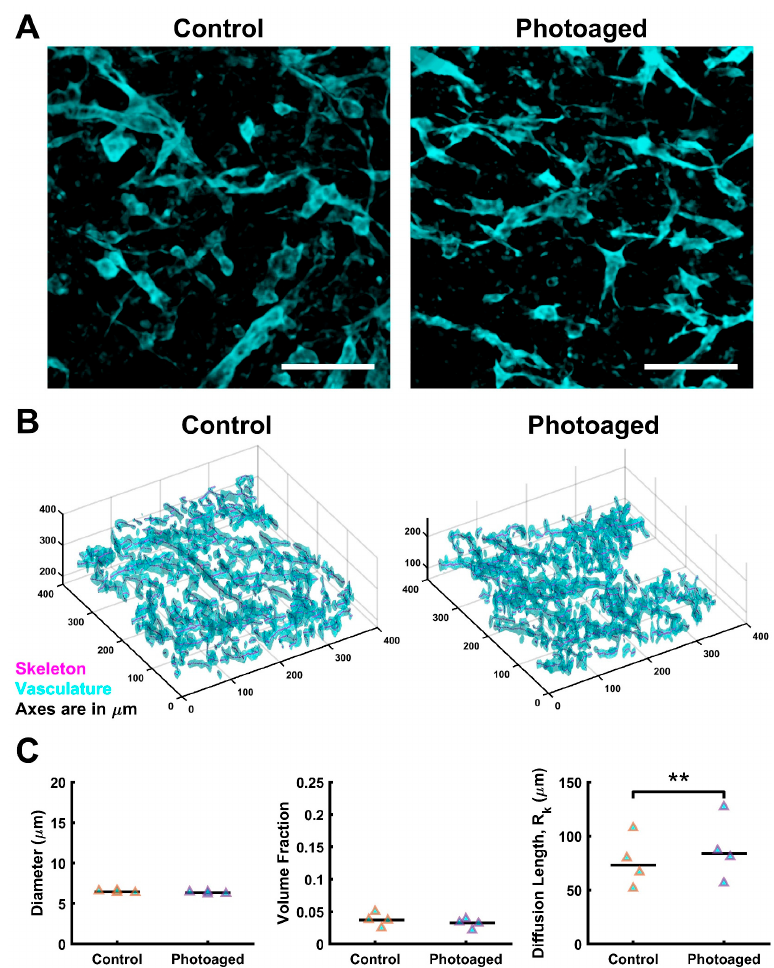
Figure 5. Vascular staining and quantification. ( A ) A comparison of maximum projections of confocal images of control v. photoaged AVHSE sub-dermis and dermis; Collagen IV marks vasculature in cyan. Scalebars are 100 µm. ( B ) Segmentation of the vascular fraction (cyan) was completed on 6 cleared sub-volumes per sample. Skeletonization was completed using segmentation data (magenta line). Shown is a representative 3D rendering of one confocal sub-volume. ( C ) Segmentation and skeletonization of vascular networks enable quantitative assessment of the morphology ( n = 4 for each condition). Vessel diameter and volume fractions remain stable when AVHSEs are photoaged and there is an increase in diffusion length for photoaged ( p < 0.01; indicated with **). Data is shown as medians (black bars) and individual data points (triangles). Images are median filtered for